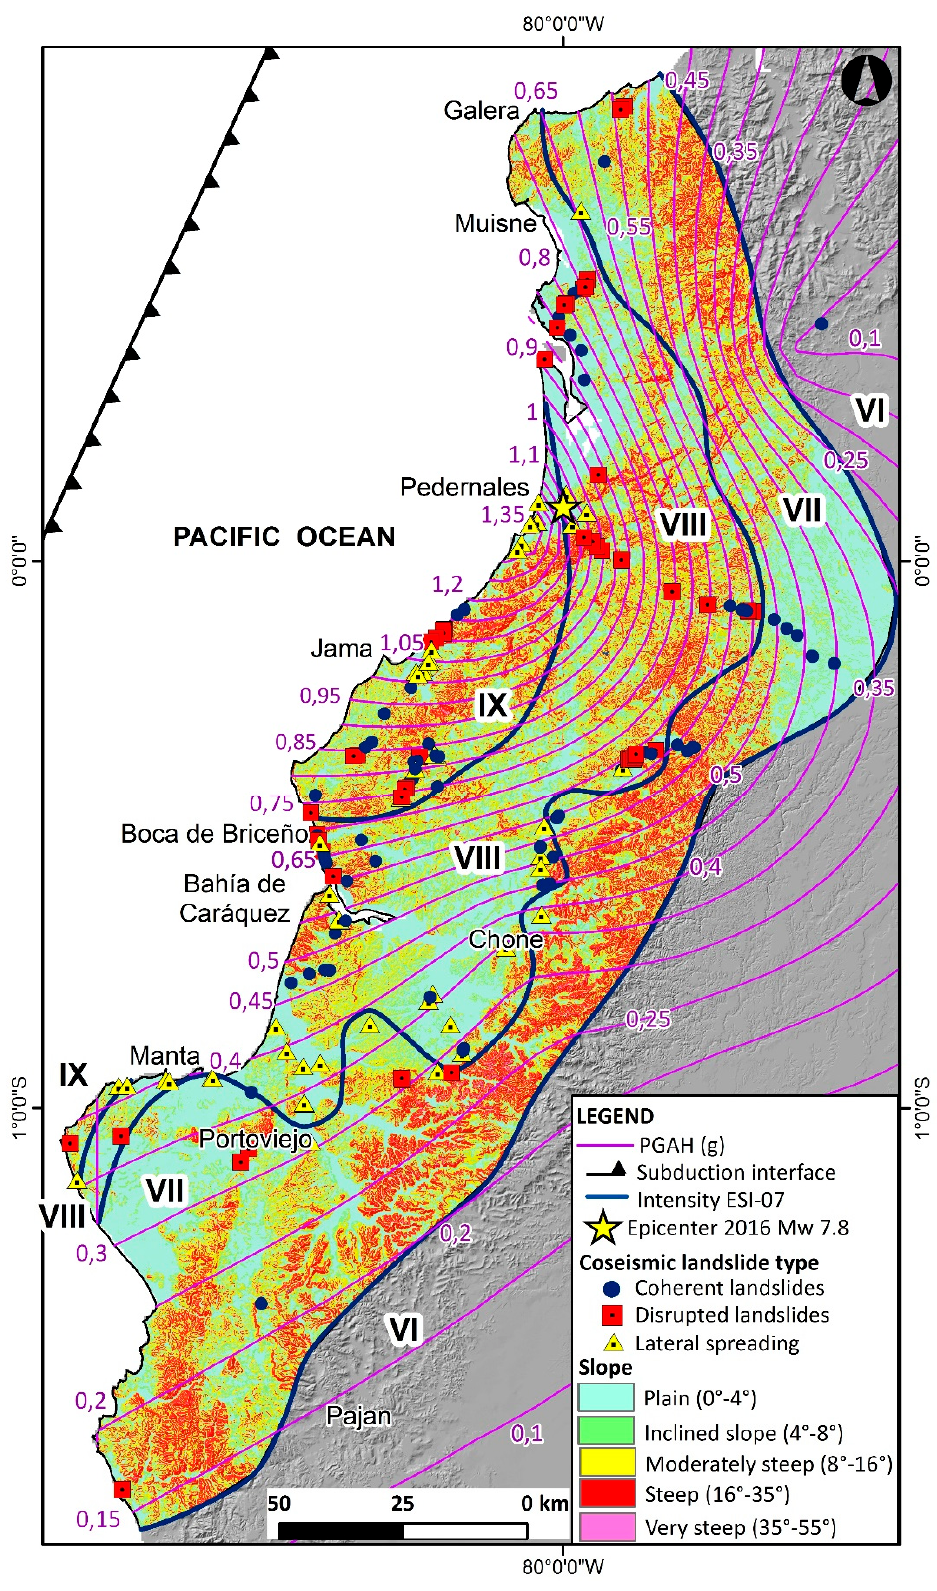
Figure 8. Simplified slope map and PGA-h isolines in the area of 2016 coseismic landslide inventory.